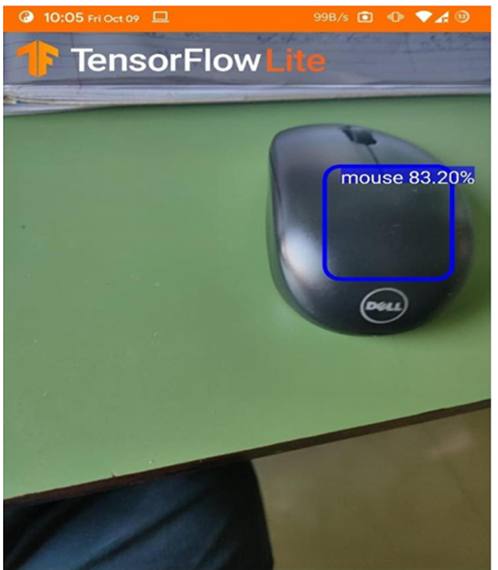
Fig 3 Detecting objects Text Recognition